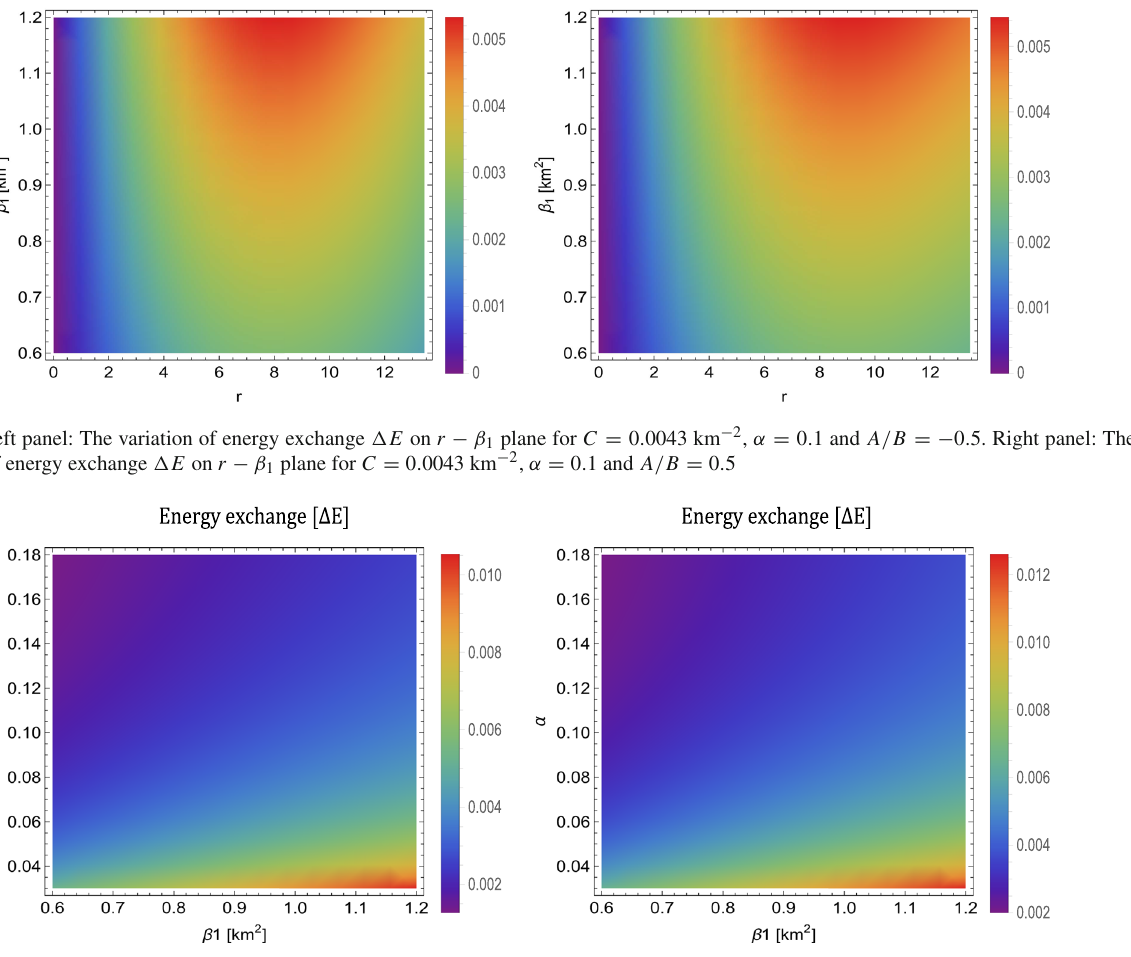
Fig. 11 Left panel: The variation of energy exchange (cid:18) E on β 1 − α plane for C = 0 . 0043 km − 2 , R = 13 . 44 km and A / B = − 0 . 5. Right panel: The variation of energy exchange (cid:18) E on r − β 1 plane for C = 0 . 0043 km − 2 , R = 13 . 44 km and A / B = 0 .